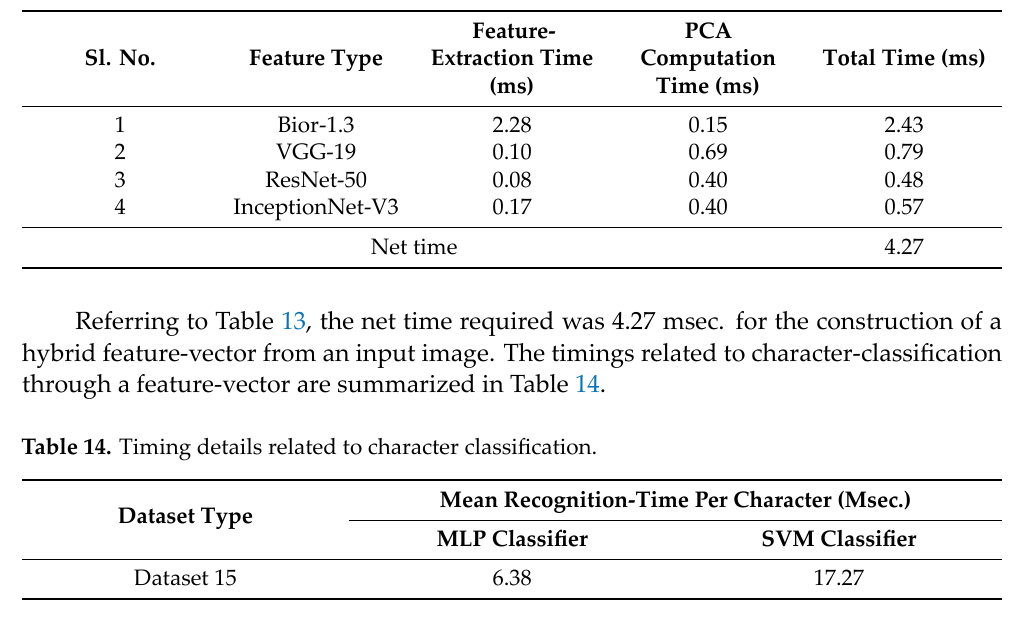
Table 13. Timing details related to the construction of feature‑vectors.